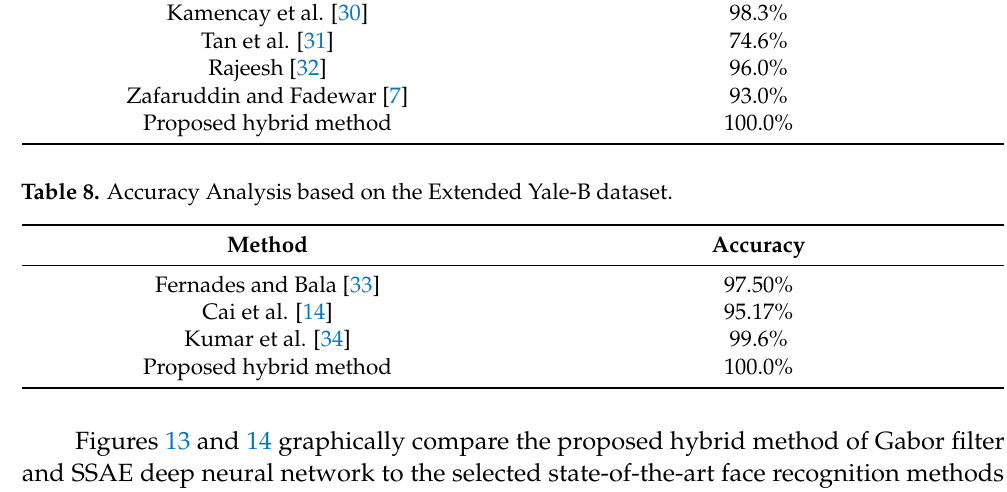
Table 8. Accuracy Analysis based on the Extended Yale-B dataset.